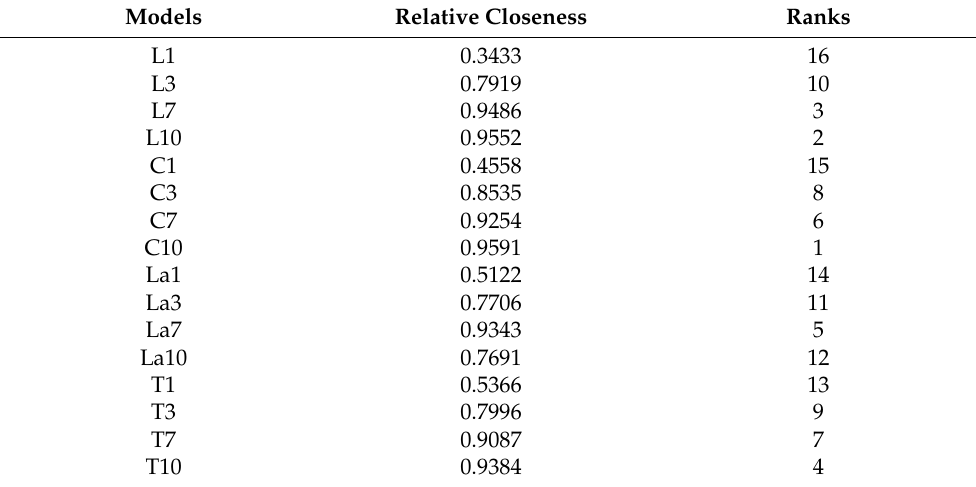
Table 18. Ranking models for Coinbase Pro dataset.